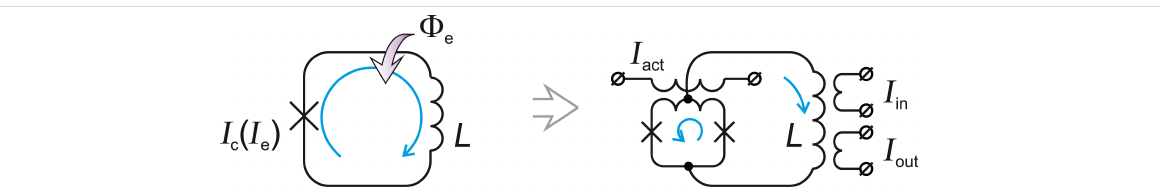
Figure 10: Notional (left) and practical (right) schematic of a parametric quantron. The cell state is conditioned by bias flux Φ e and current I e control- ling the critical current I c of the Josephson junction. L is the loop inductance. In practice, the single Josephson junction is substituted with a SQUID controlled by the activation current I act . I in / I out are input/output currents.